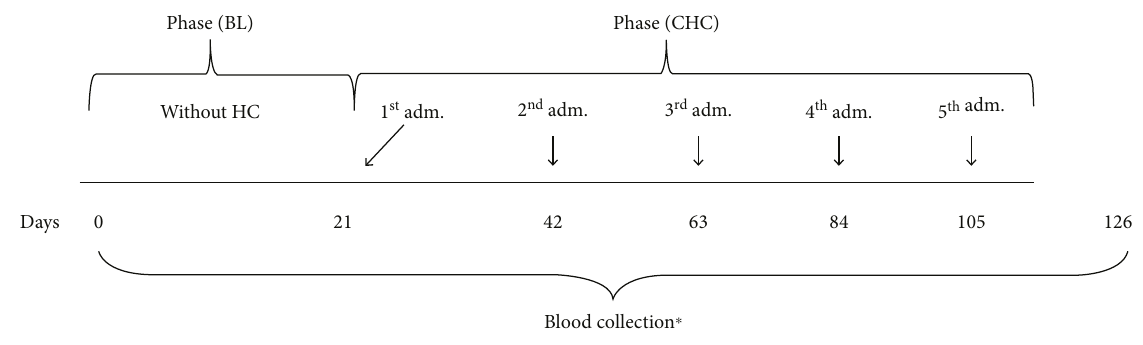
Figure 1: Experimental design where blood sampling is represented as well as the administration of hormonal contraceptive during the BL (baseline) and CHC (combined hormonal contraceptive) phases in six female capuchin